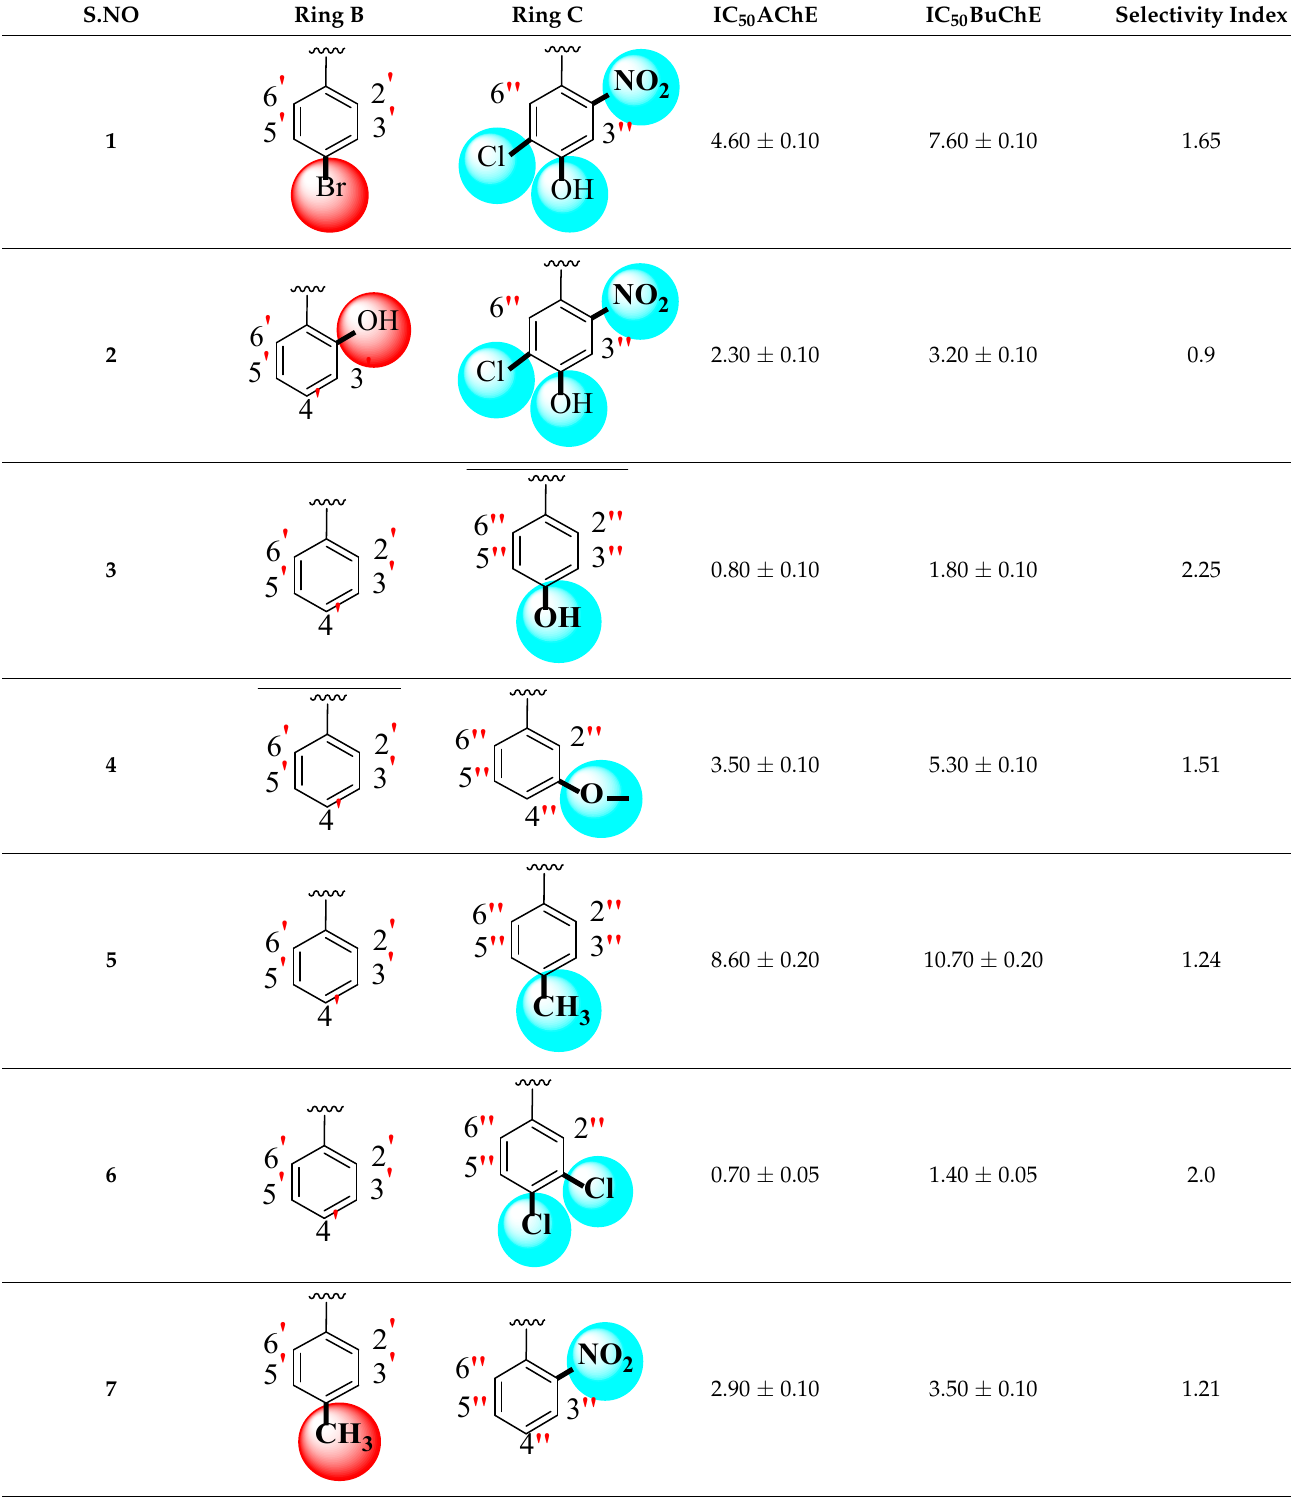
Figure 4. General structure of benzimidazole-bearing 1,3-thiazole scaffolds (1 – 24). Table 1. IC 50 values and selectivity index values of tested benzimidazole-based thiazole derivatives determined for AChE and BuChE.